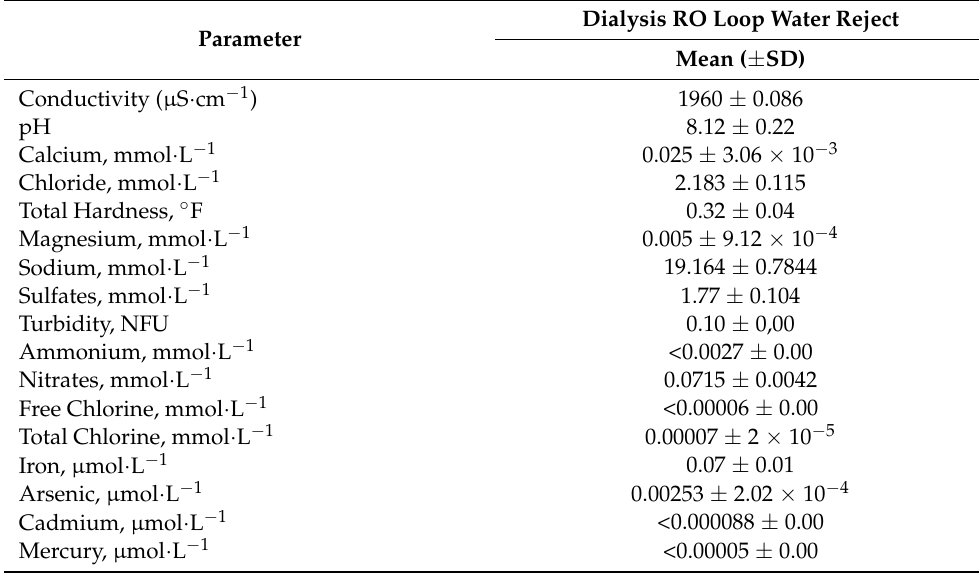
Table 1. Physical and chemical parameters measured in dialysis RO rejects from Polyclinic Saint C ô me (N =